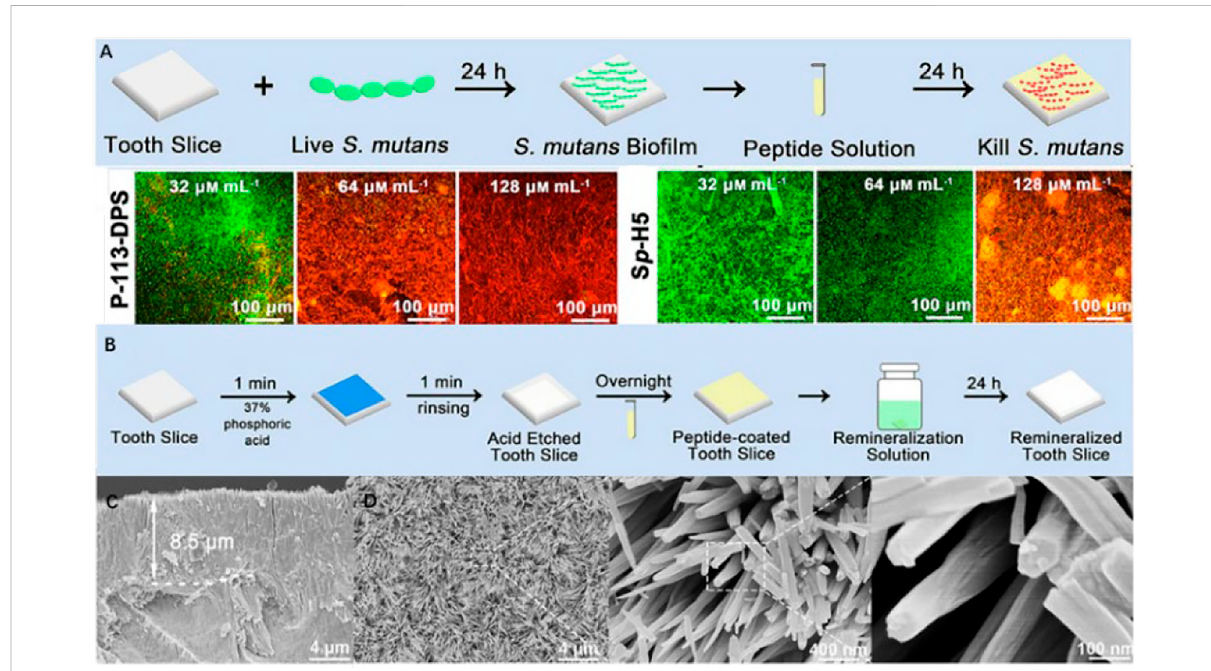
FIGURE 6 (A) Schematic diagram of anti- S. mutans bio fi lm on the enamel surface and fl uorescence images (×20) of S. mutans bio fi lm in various concentrations of P-113-DPS and Sp-H5 solutions. (B) Remineralization experiment schematic. (C) 8.5 μ m needle-like remineralized layers formed byP-113-remineralizedlayersand (D) itsFE-SEMmicrographs(×5000,×50,000,and×200,000).Reprintedwithpermissionfrom[(Zhouetal.,2021) ]. Copyright © 2021 American Chemical